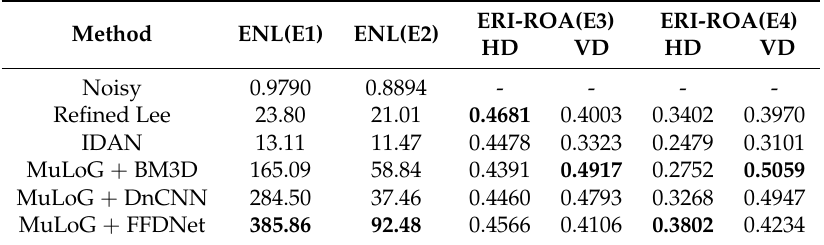
Figure 16. The denoising results for GF-3 PolSAR image with L = 1: ( a – f ) Noisy image, Refined Lee, IDAN, MuLoG + BM3D, MuLoG + DnCNN, and MuLoG + FFDNet, respectively. Table 7. The quantitative comparison of different methods for CETC-38th airborne SAR.